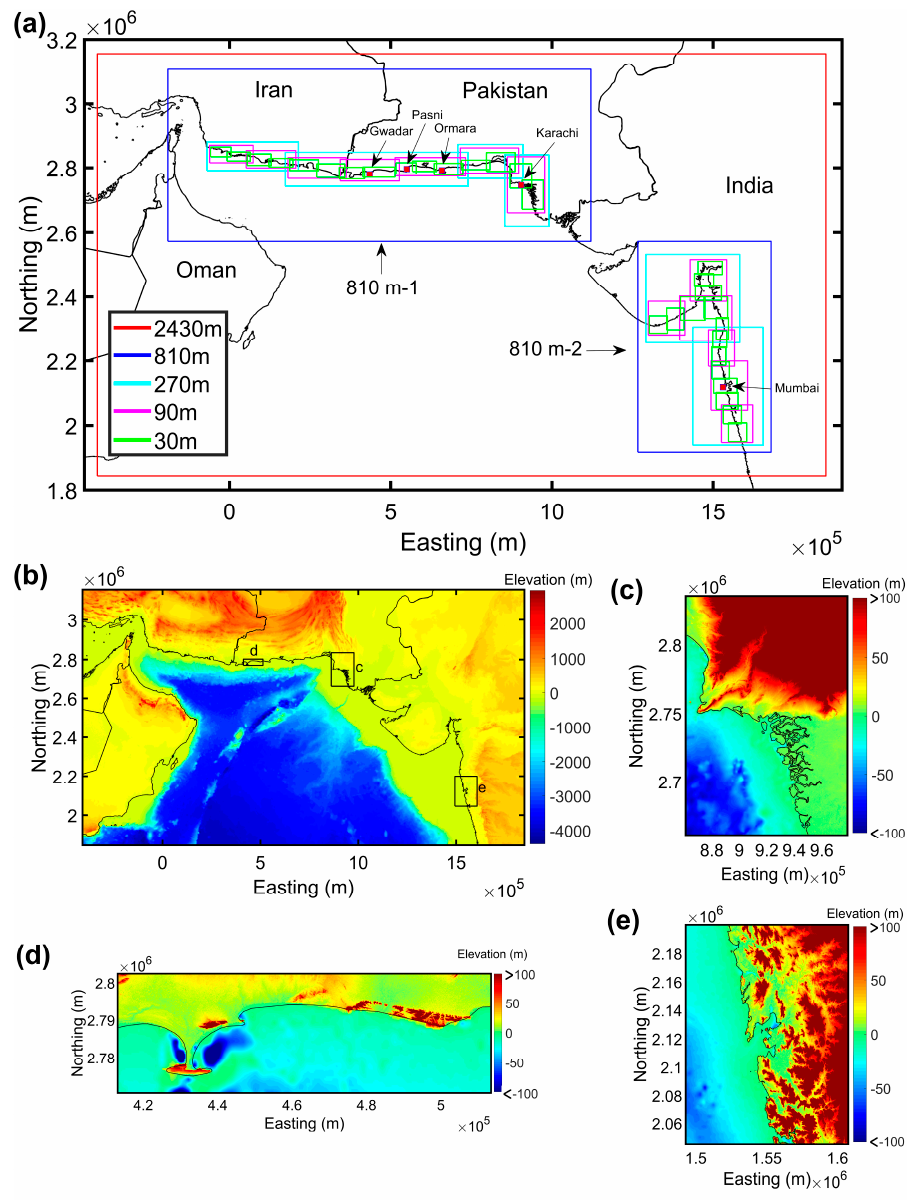
Figure 4. ( a ) Tsunami computational domain (grids with resolutions of 2430, 810, 270, 90, and 30 m). Bathymetry and digital elevation model data for: ( b ) 2430 m region, ( c ) 90 m region around Karachi, ( d ) 30 m region around Gwadar, and ( e ) 90 m region around